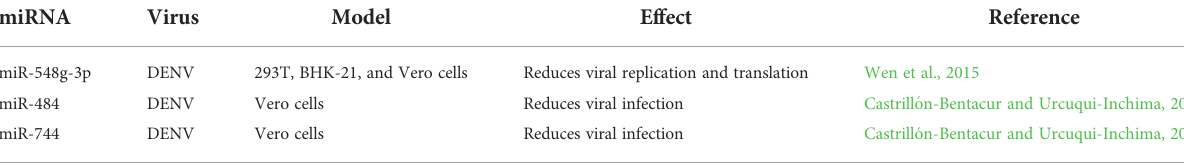
TABLE 1 Cellular miRNAs with a target in fl avivirus genomes.